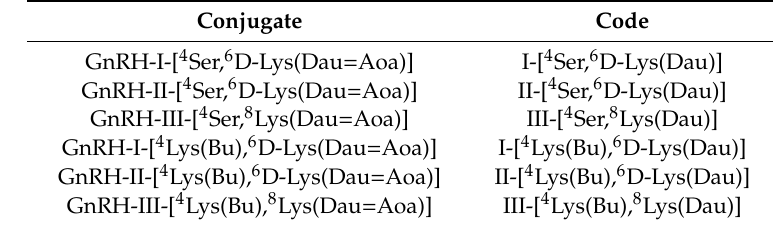
Table 1. Daunorubicin–gonadotropin-releasing hormone (Dau–GnRH) conjugates investigated in this